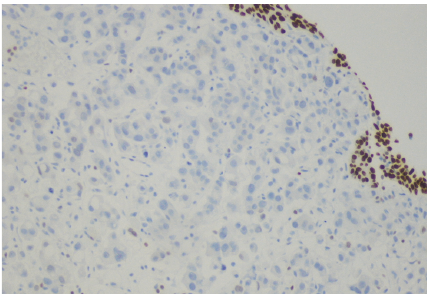
Figure 7: Bladder tumor with negative stain for GATA 3 in neoplastic cells.